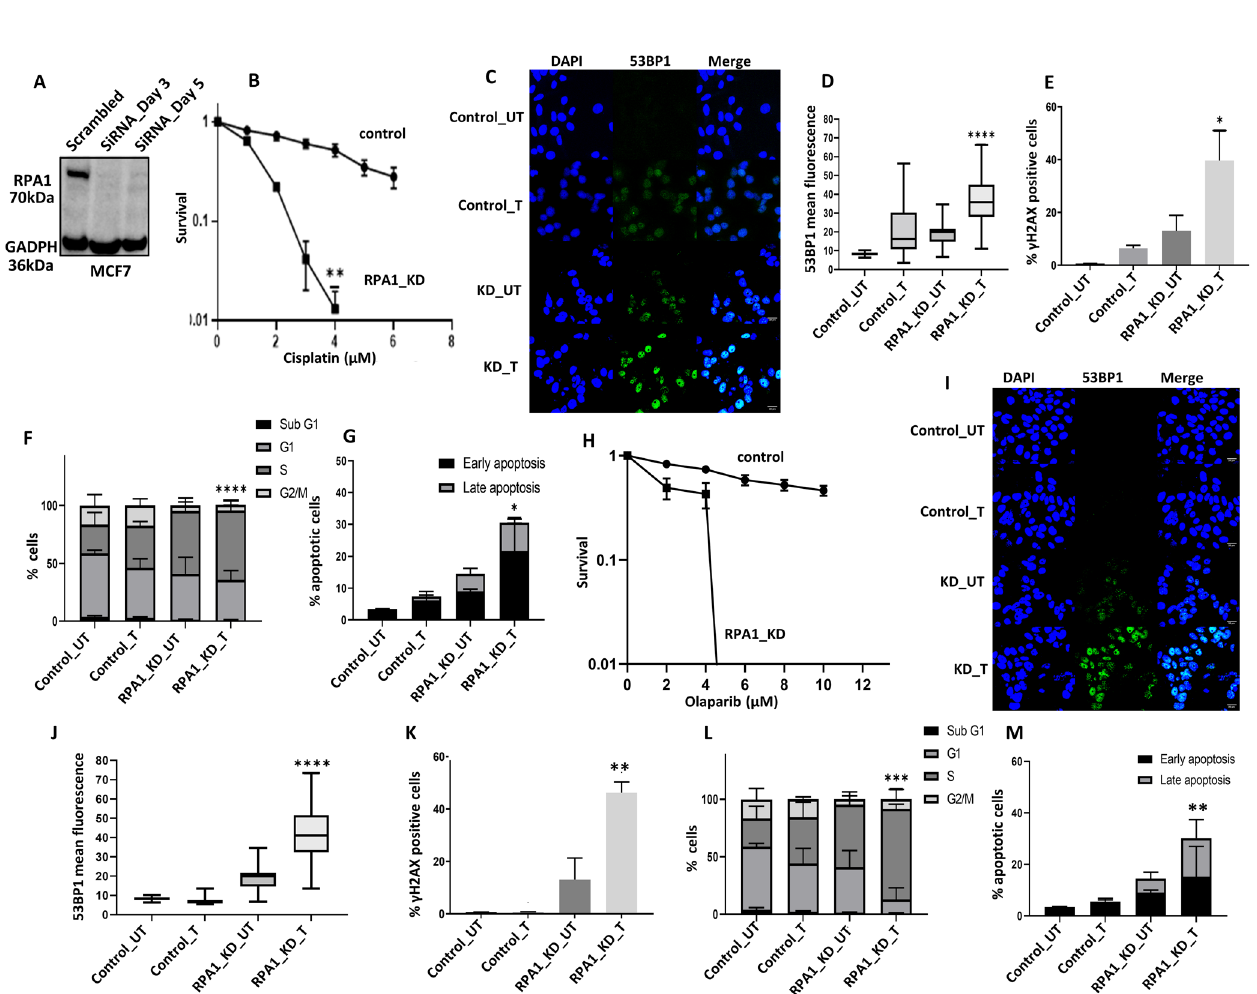
Fig. 5 RPA1 depletion and cisplatin or Olaparib sensitivity in breast cancer cells. A RPA1 siRNA knock down in MCF7 cells. Lysates were collected at day3 and day5. B Clonogenic survival assay for cisplatin sensitivity in MCF7 cells control and MCF7_RPA1_KD cells. C Representative photo micrographic images for immuno fl uorescence staining of 53BP1 in MCF7 control MCF7_RPA1_KD cells treated with Cisplatin (5 μ M) for 24 h. D Quanti fi cation of 53BP1 nuclear fl uorescence by ImageJ software. E Quanti fi cation of γ H2AX positive cells by fl ow cytometry. F Cell cycle analysis by fl ow cytometry. G Annexin V analysis for apoptotic cells in MCF7 control and RPA1_knock down cells treated with 5 μ M cisplatin for 24 h. H Clonogenic survival assay for Olaparib sensitivity in MCF7 cells control and MCF7_RPA1_KD cells. I Representative photo micrographic images for immuno fl uorescence staining of 53BP1 in MCF7 control MCF7_RPA1_KD cells treated with Olaparib (6 μ M) for 24 h. J Quanti fi cation of 53BP1 nuclear fl uorescence by ImageJ software. K Quanti fi cation of γ H2AX positive cells by fl ow cytometry. L Cell cycle analysis by fl ow cytometry. M Annexin V analysis for apoptotic cells in MCF7 control and RPA1_knock down cells treated with 6 μ M Olaparib for 24 h. Figures are representative of 3 or more experiments. Statistical analysis was conducted as on GraphPad Prism7 software. To compare between two groups, Student T tests analysis was performed. One-way ANOVA was performed to compare between more than two groups (variances analyses). Two-way ANOVA was used to analyse two variables such as Annexin V analysis and cell cycle analysis. All experiments were expressed as means ± standard deviation S.D. of three independent experiments. Error bars represent standard error of mean between experiments. UN untreated, T treated. * P value <0.05, ** P value <0.001, *** P value